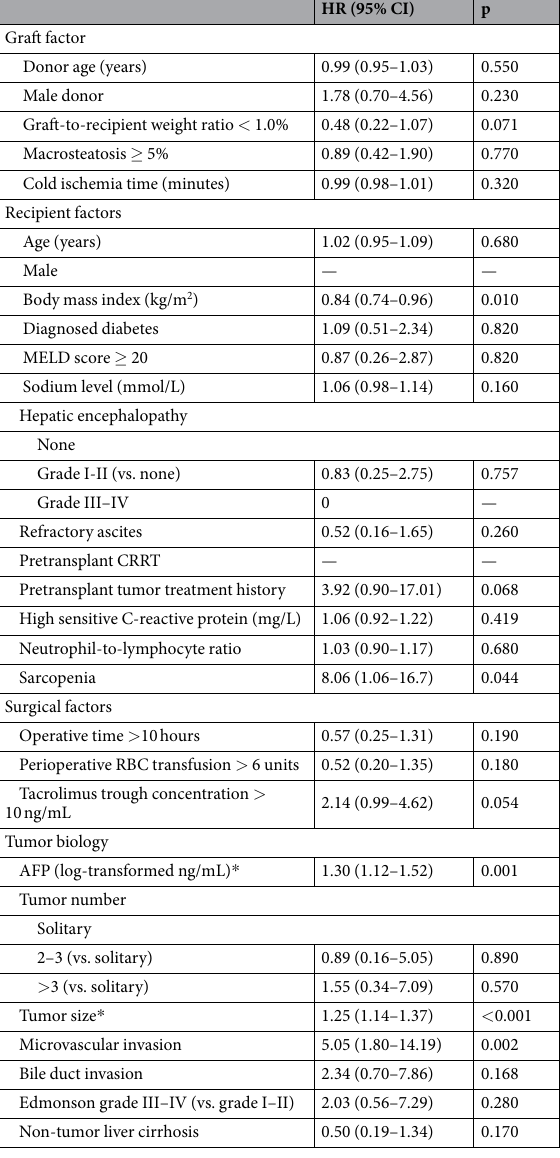
Table 2. Descriptive statistics and univariable analysis. Data are presented as median (25th percentile, 75th percentile) or frequency (percent). Sarcopenia was defined based on transverse psoas muscle thickness. AFP, alpha-fetoprotein; MELD, model for end-stage liver disease; RBC, red blood cell. CRRT, continuous renal replacement therapy. * Hazard ratios and P values were calculated for log-transformed values due to skewed